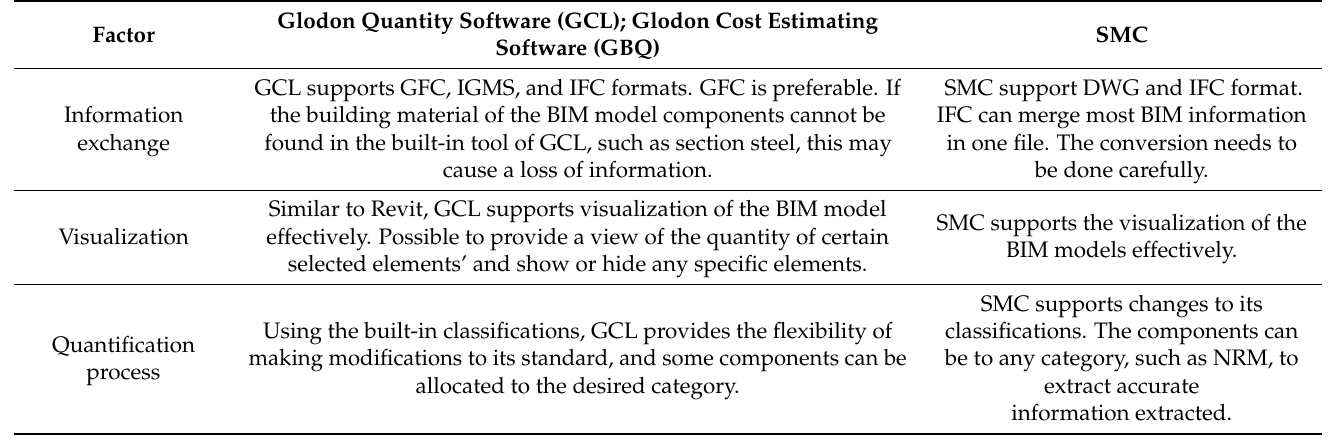
Table 7. Glodon Quantity Software–GCL and Glodon Cost estimating software—GBQ (model visualization can only be done in GCL) and